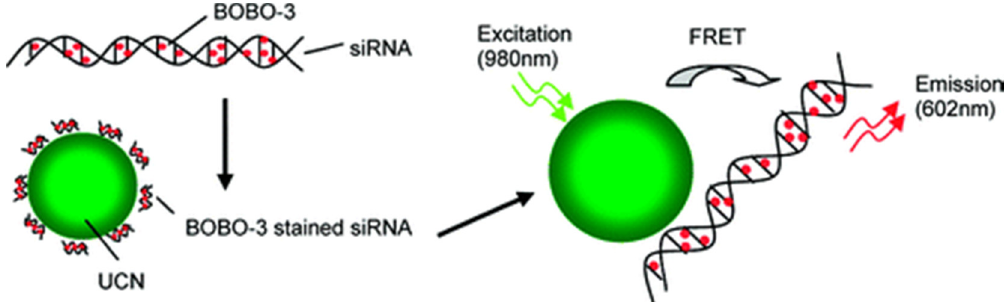
Figure 14. Schematic drawing of FRET-based UCNPs/siRNA-BOBO-3 complex system. siRNA are stained with BOBO-3 dyes, and the stained siRNA are attached to the surface of NaYF 4 :Yb,Er nanoparticles. Upon excitation of the nanoparticles at 980 nm, energy is transferred from the donor (UCNPs) to the acceptor (BOBO-3). Reprinted with permission from [42]. Copyright American Chemical Society,